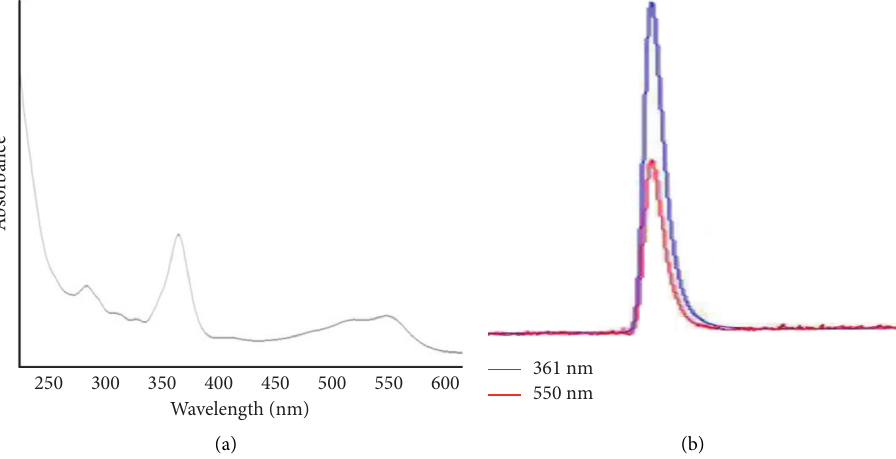
Figure 1: Sensitivity of cyanocobalamin: (a) absorption spectra of cyanocobalamin solution; (b) comparison of sensitivity on wavelength 361 and 550nm through HPLC chromatogram. Table 2: Calibration curves, LOD, and LOQ of HPLC analysis for cyanocobalamin. Compound